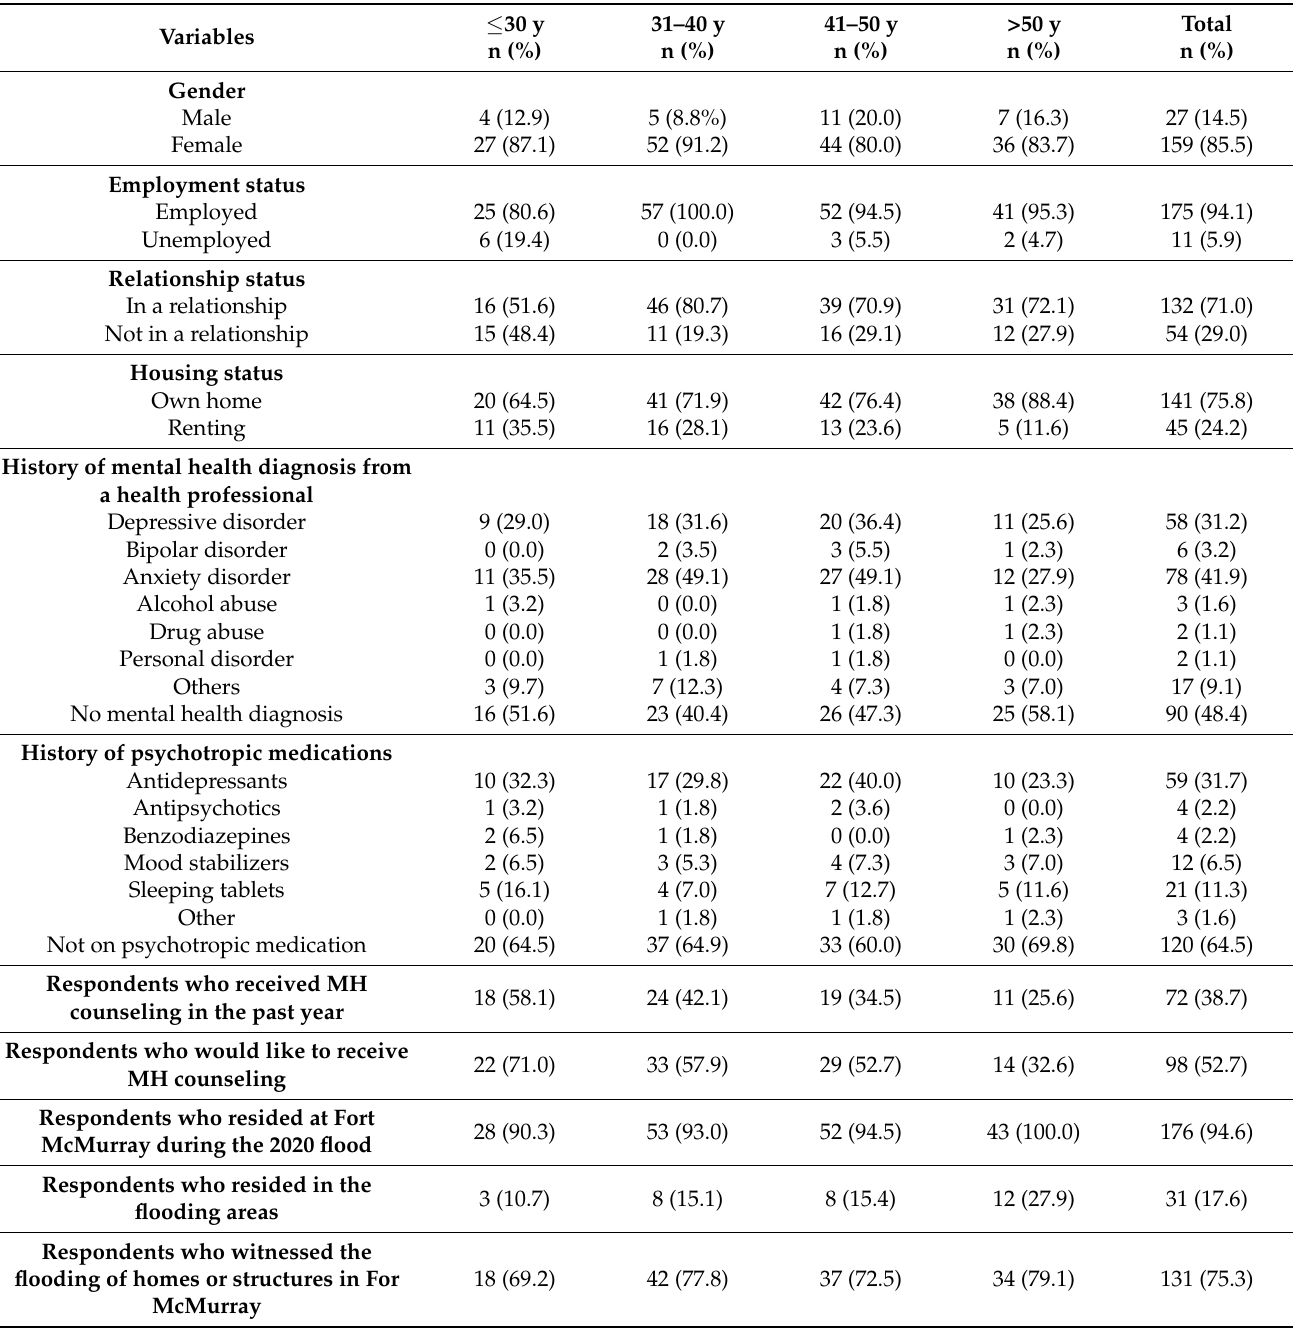
Table 1. Demographic information, clinical characteristics and support received by